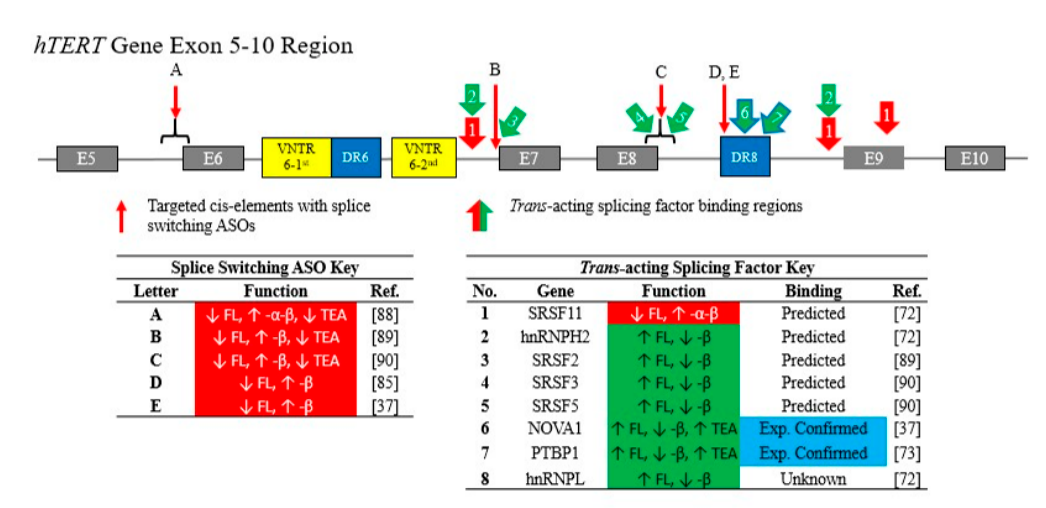
Figure 3. Therapeutically targeting hTERT splicing. Five regions within the RT-domain of hTERT pre-mRNA have been identified as potential cis -elements that are targetable with splice switching ASOs. Each has been identified to promote the alternative splicing of hTERT away from the FL transcript towards either the - β or - α - β variants and decrease telomerase enzyme activity in cancer cells (red arrows noted by the letters “A-E”). In addition, eight trans -acting RNA binding proteins have been identified to regulate hTERT FL splicing, either by repressing (red arrows noted by the number “1”) or enhancing the inclusion of exons 7 and 8 (green arrows noted by the numbers “2–8”). Although the majority of trans -acting splicing factors have been predicted to bind within the RT-domain, only NOVA1 and PTBP1 have been experimentally confirmed to directly bind to hTERT pre-mRNA within the DR8 region and promote the FL hTERT , telomerase activity, and telomere length maintenance in cancer cells. Abbreviations: ASO = antisense oligonucleotide; B6 = block 6; DR6 = direct repeat 6; DR8 = direct repeat 8; hnRNP = heterogeneous nuclear ribonucleoproteins; hTERT = human telomerase reverse transcriptase; PTBP1 = polypyrimidine-tract binding protein 1; RT = reverse transcriptase; SF = splicing factor; SRSF = serine / arginine-rich splicing factor; TEA = telomerase enzyme activity; VNTR = variable number tandem